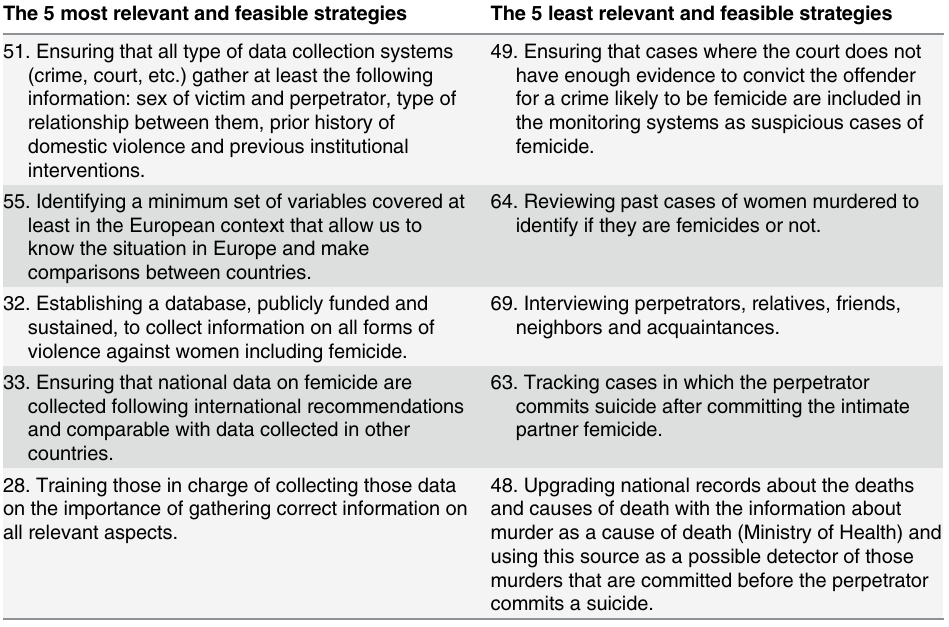
Table 3. Summary of the most and the least relevant and feasible strategies to build femicide data col- lection systems according to participants ’ opinions. The 5 most relevant and feasible strategies The 5 least relevant and feasible